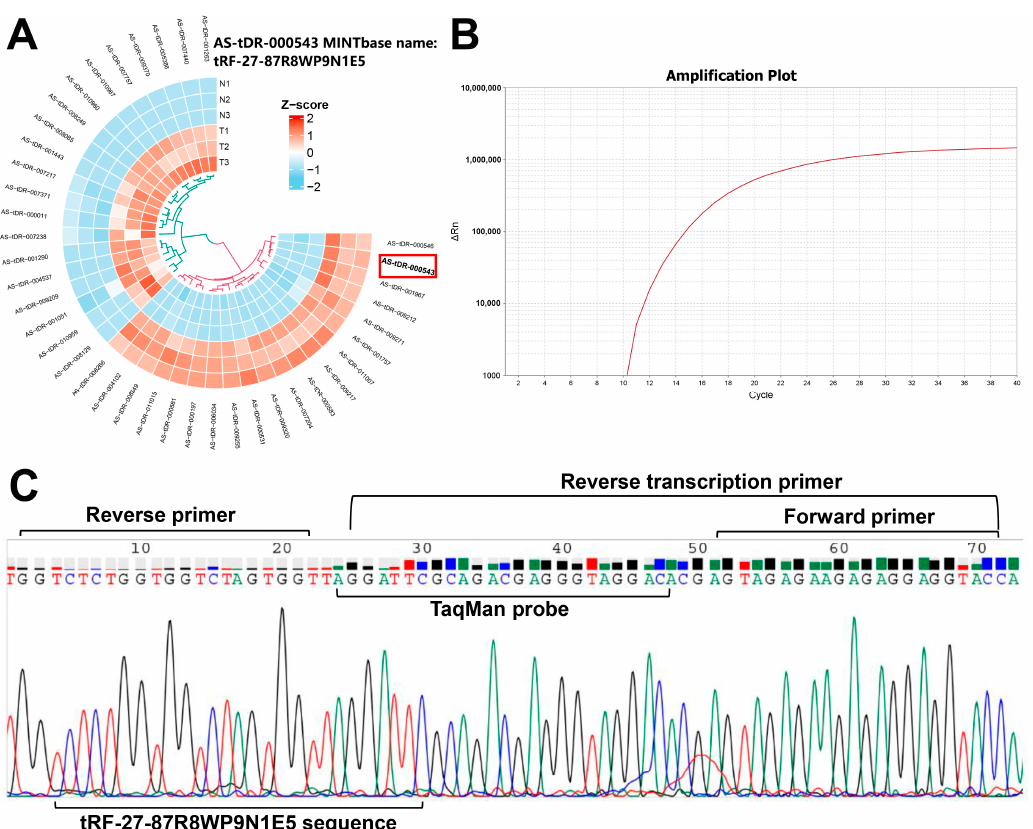
Figure 2. Amplification curve and design of qRT-PCR primers for tRF-27. ( A ) Screening of tRF-27 as a gastric cancer-related tRF. ( B ) Amplification curve. ( C ) Results of T-A cloning of qRT-PCR prod- ucts.